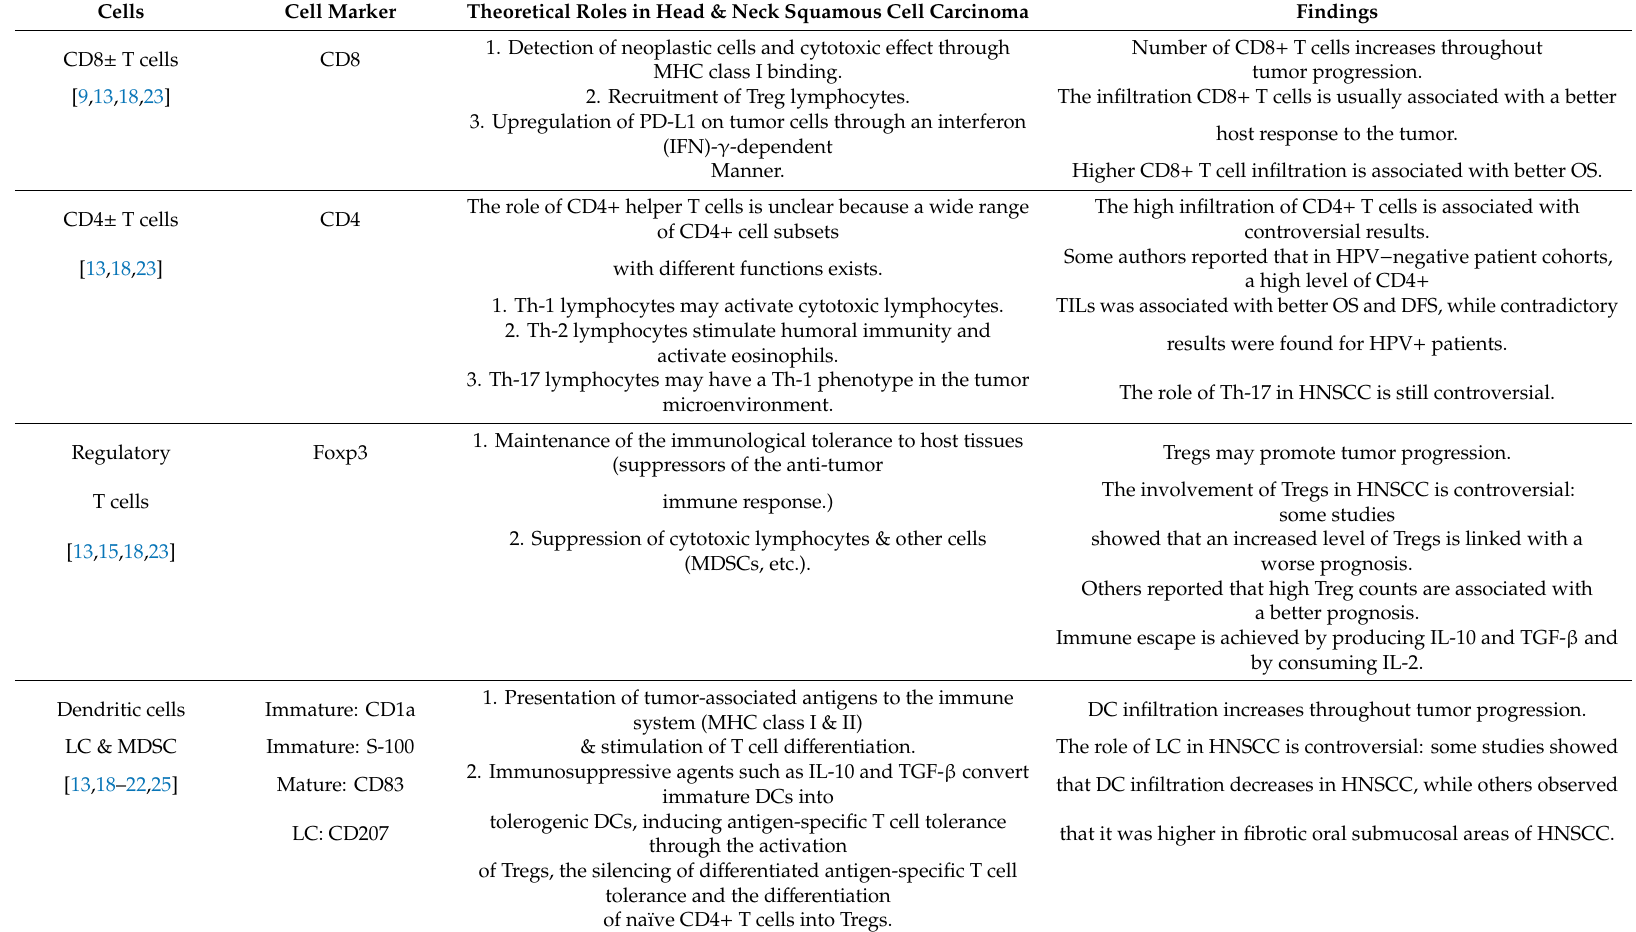
Table 1. Immune cell